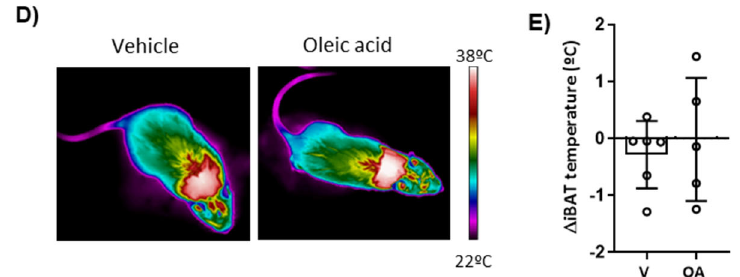
Figure 6. Effects of the intracerebroventricular (ICV) administration of oleic acid on body weight, food intake and brown adipose tissue (BAT) thermogenesis in CPT1C-KO mice. ( A ) Body weight (BW) change and ( B ) cumulative food intake measured during 48 h of treatment. ( C ) mRNA expression of the thermogenic markers UCP1, PGC1 α and PRDM16 in BAT after 48 h ICV injection of oleic acid. ( D ) Representative infrared thermal images and ( E ) quantification of interscapular BAT (iBAT) temperature changes measured during the treatment. Data are represented as mean ± SEM (n = 7–9 per group for A – C panels and n = 5–6 per group for D , E panels). OA: oleic acid; V: vehicle.